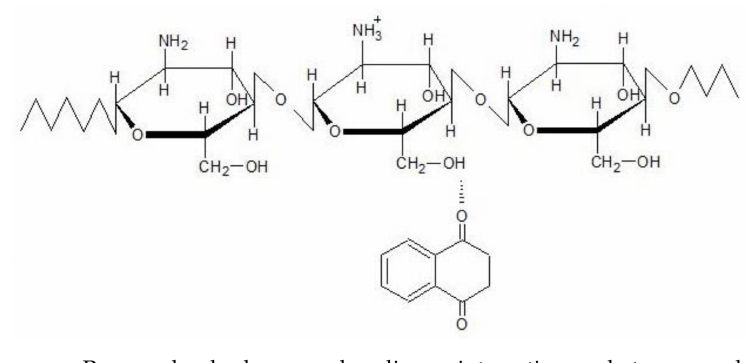
Figure 5. Proposed hydrogen bonding interactions between chitosan and 1,4-naphthoquinone